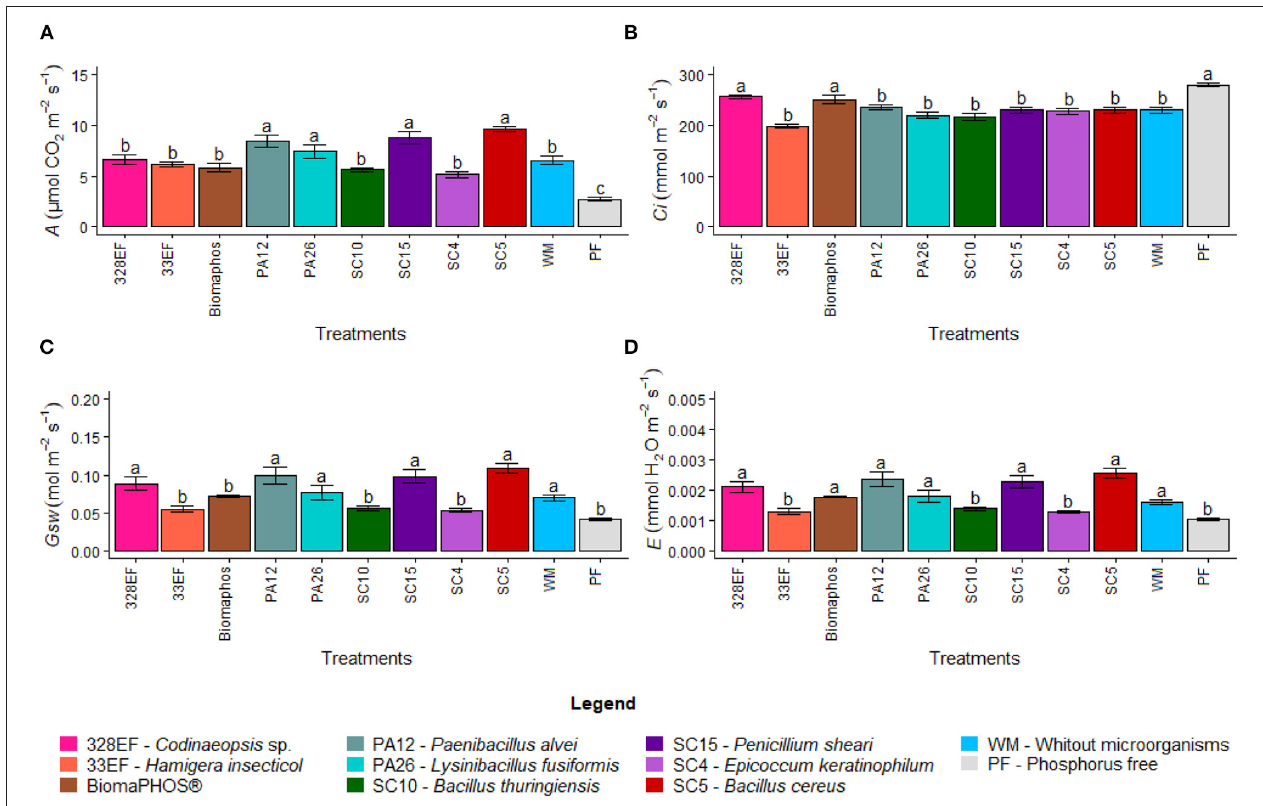
FIGURE 3 | Photosynthetic rate ( A ) (A) , internal CO 2 concentration ( Ci ) (B) , stomatal conductance ( Gsw ) (C) , and transpiration rate ( E ) (D) in soybean plants ( G. max) grown in nutrient solution providing calcium phosphate (CaHPO 4 ) as a phosphate source and inoculated with four bacterial strains and four fungal strains. Means followed by the same letter do not differ from one another according to the Scott-Knott test at 5%